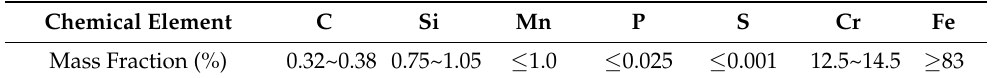
Table 1. Chemical composition of S136D mold steel (wt.%).